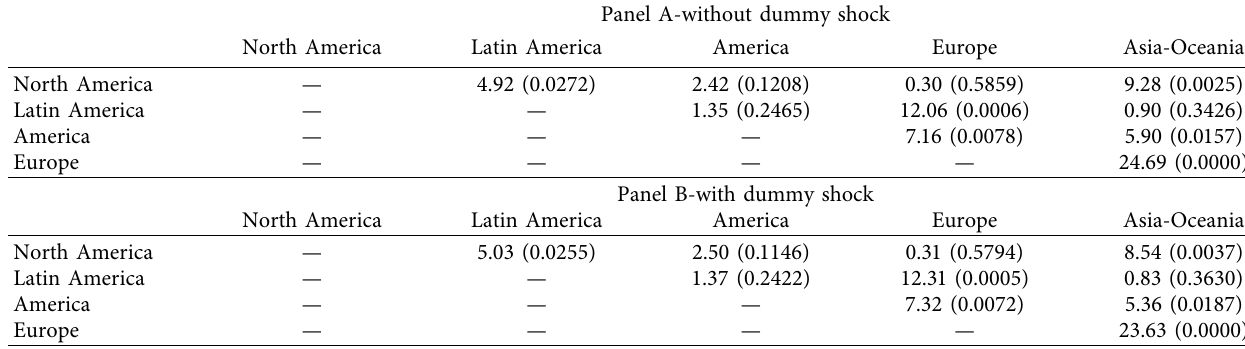
Table 5: Comparison between coefficients of regressions by